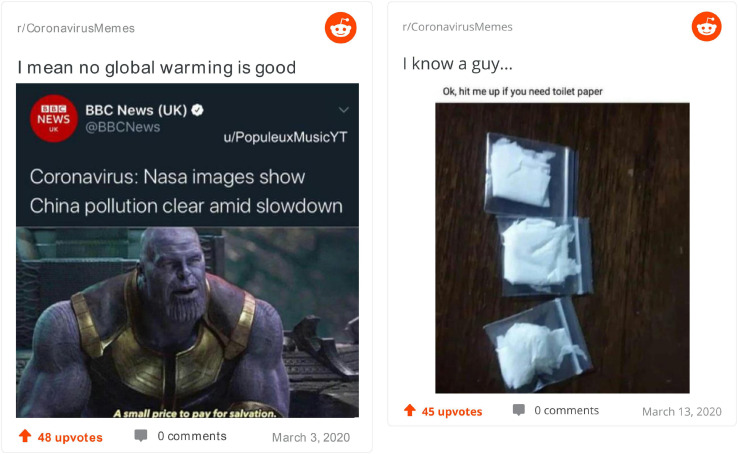
Top elaborate memes.